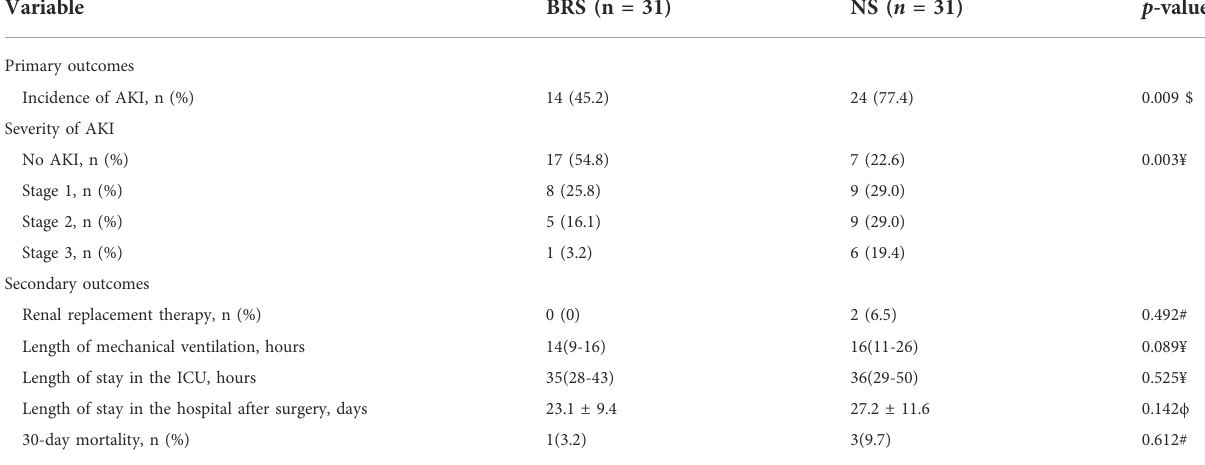
TABLE 3 Primary and secondary